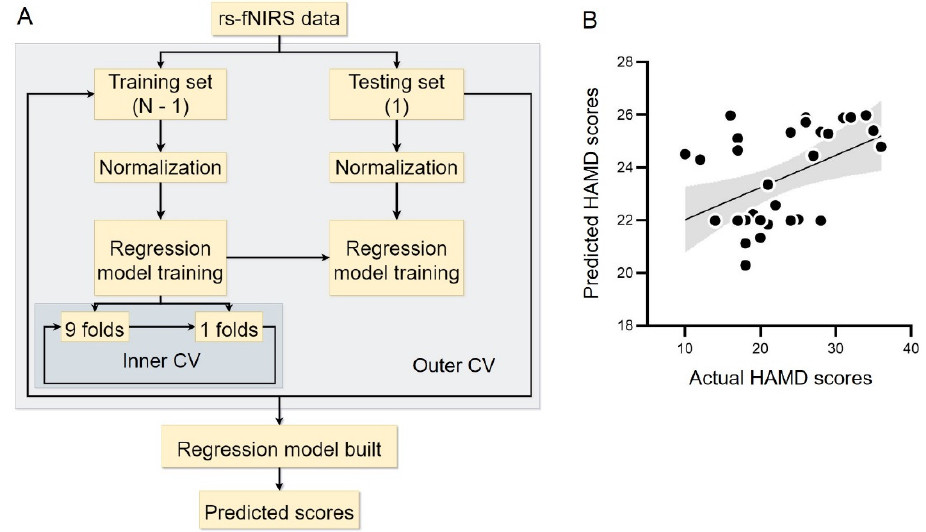
Figure 6. ( A ) The flow chart of prediction analyses based on the support vector regression (SVR) model. ( B ) The correlation between predicted and actual HAMD scores in the depression group. The shadow indicates 95% confidence interval. Rs-fNIRS, resting-state functional near-infrared spectroscopy. CV, cross validation. HAMD, Hamilton Depression Rating Scale.